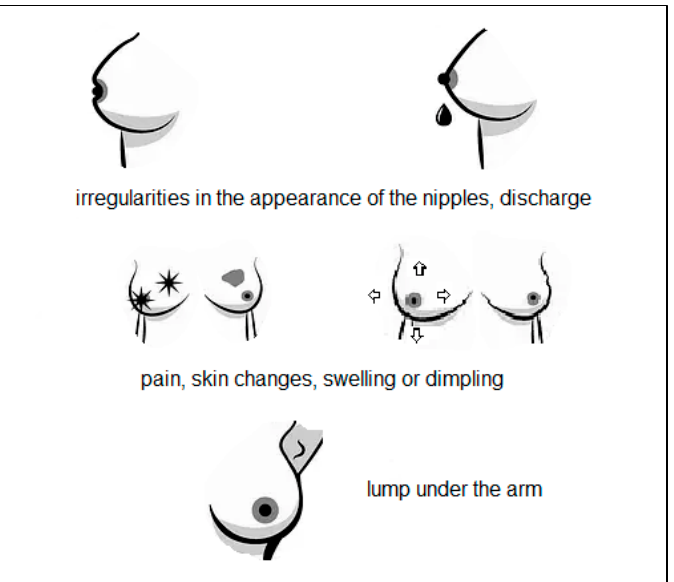
Figure 3. Most commonly observed breast cancer clinical symptoms.